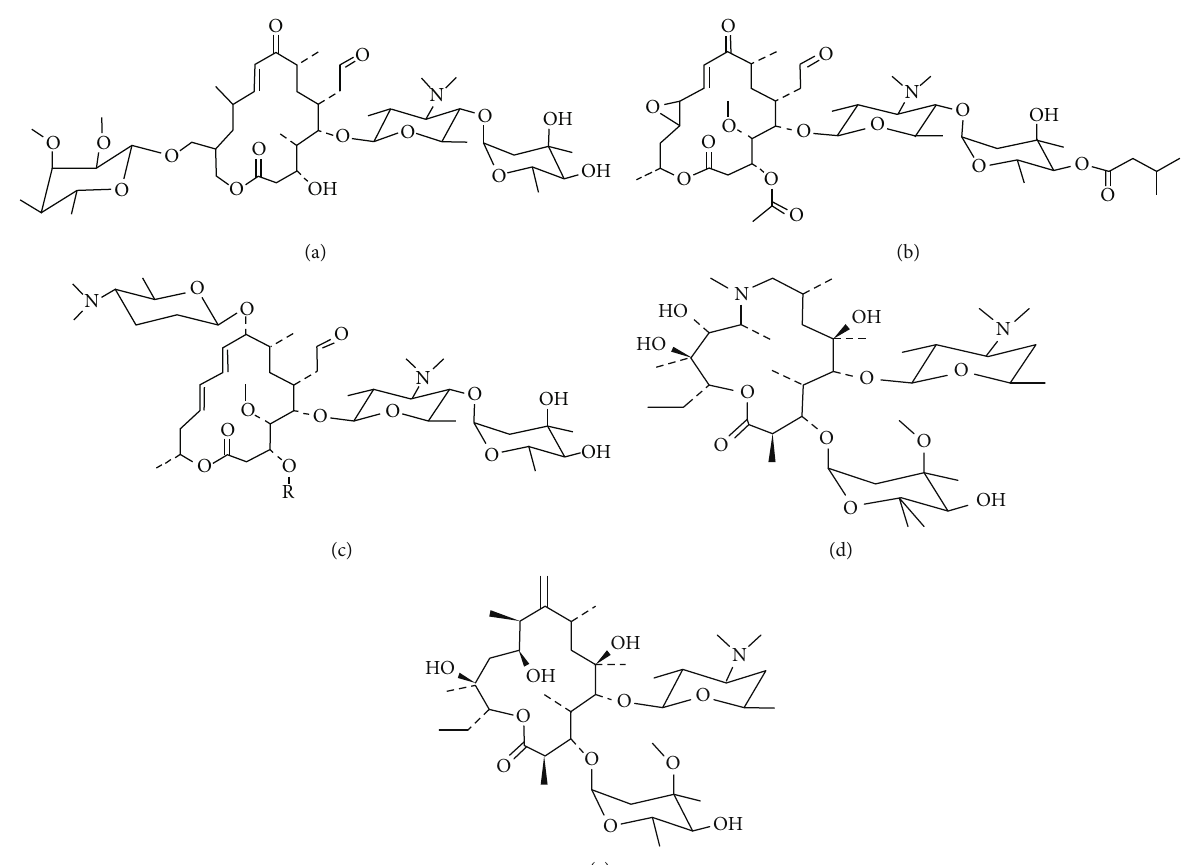
Figure 4: The structures of (a) tylosin, (b) carbomycin A, (c) spiramycin, (d) azithromycin, and (e) erythromycin